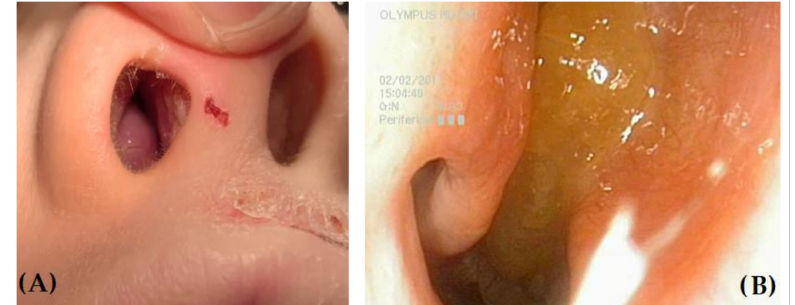
Figure 2. ( A ) Anterior rhinoscopy in a child with allergic rhinitis and atopic dermatitis, showing markedly hypertrophic right inferior turbinate. ( B ) Nasal polyp in the right nasal cavity: note the difference in color and morphology in the two